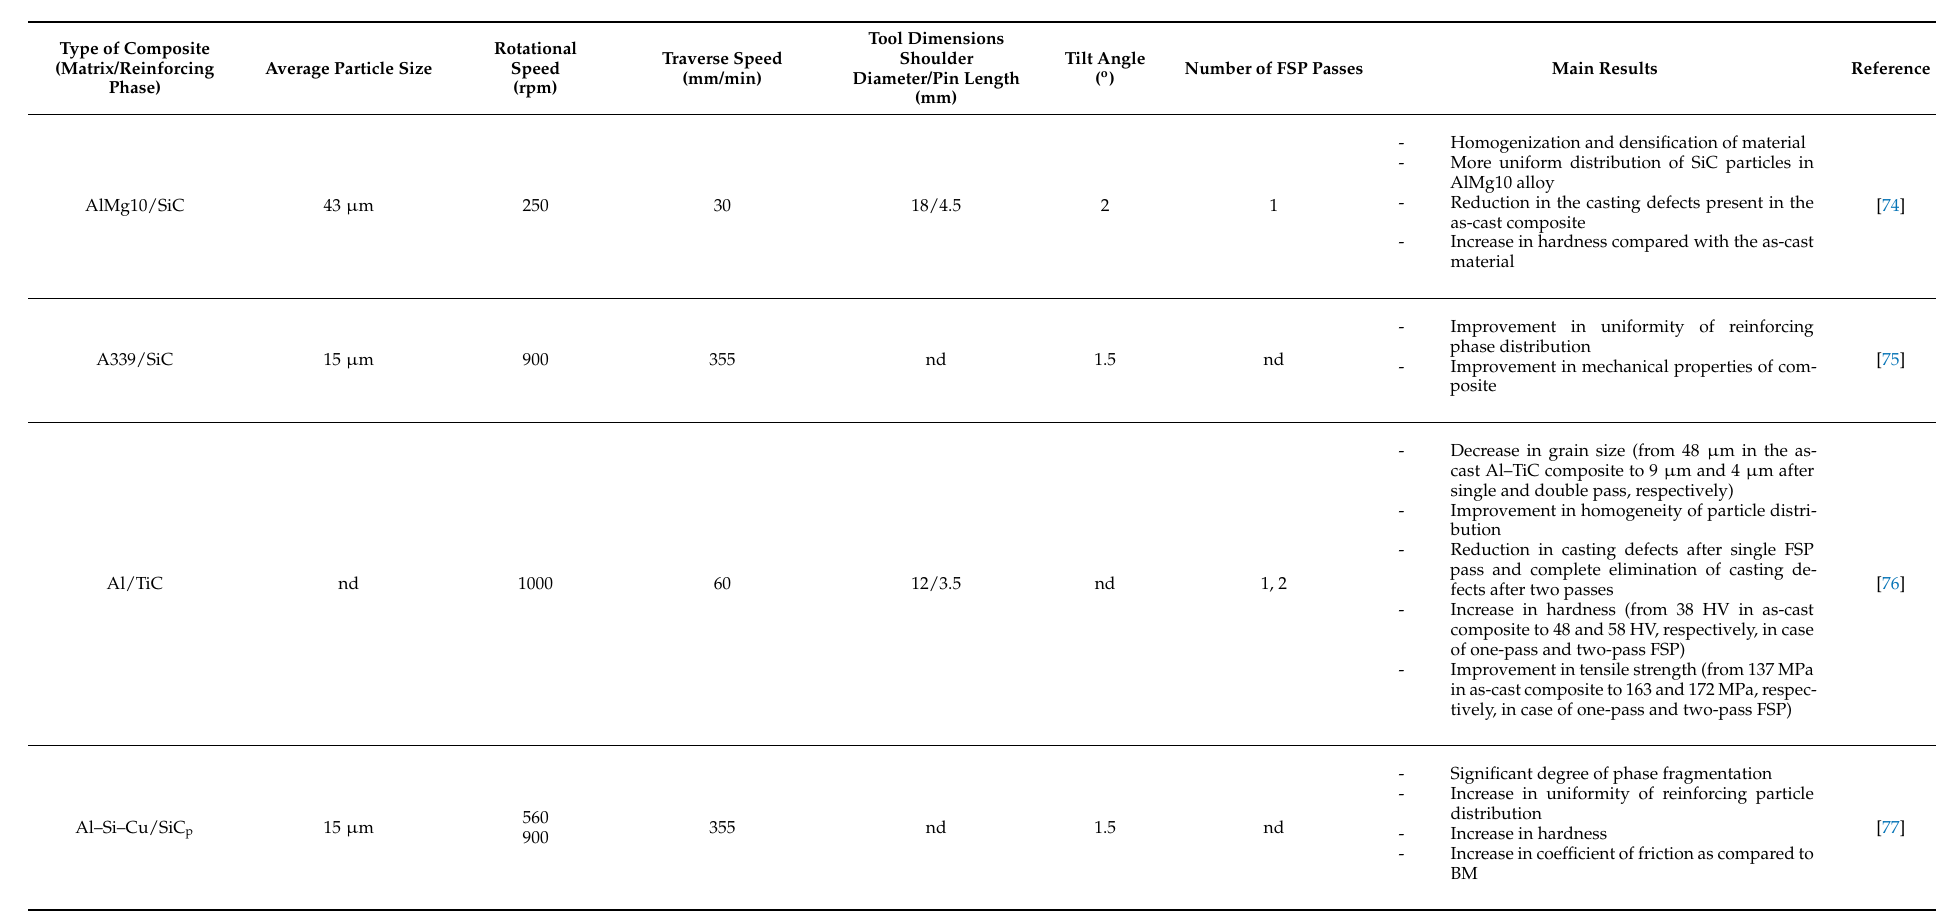
Table 5. List of cited